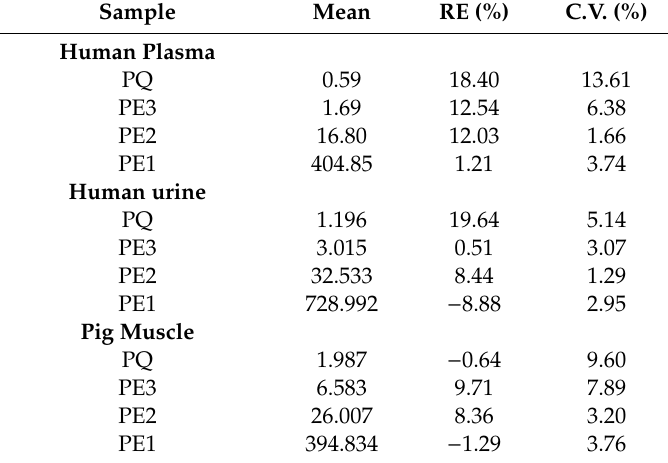
Table 2. Accuracy and precision for calibration standards in human plasma, human urine, and pig muscle